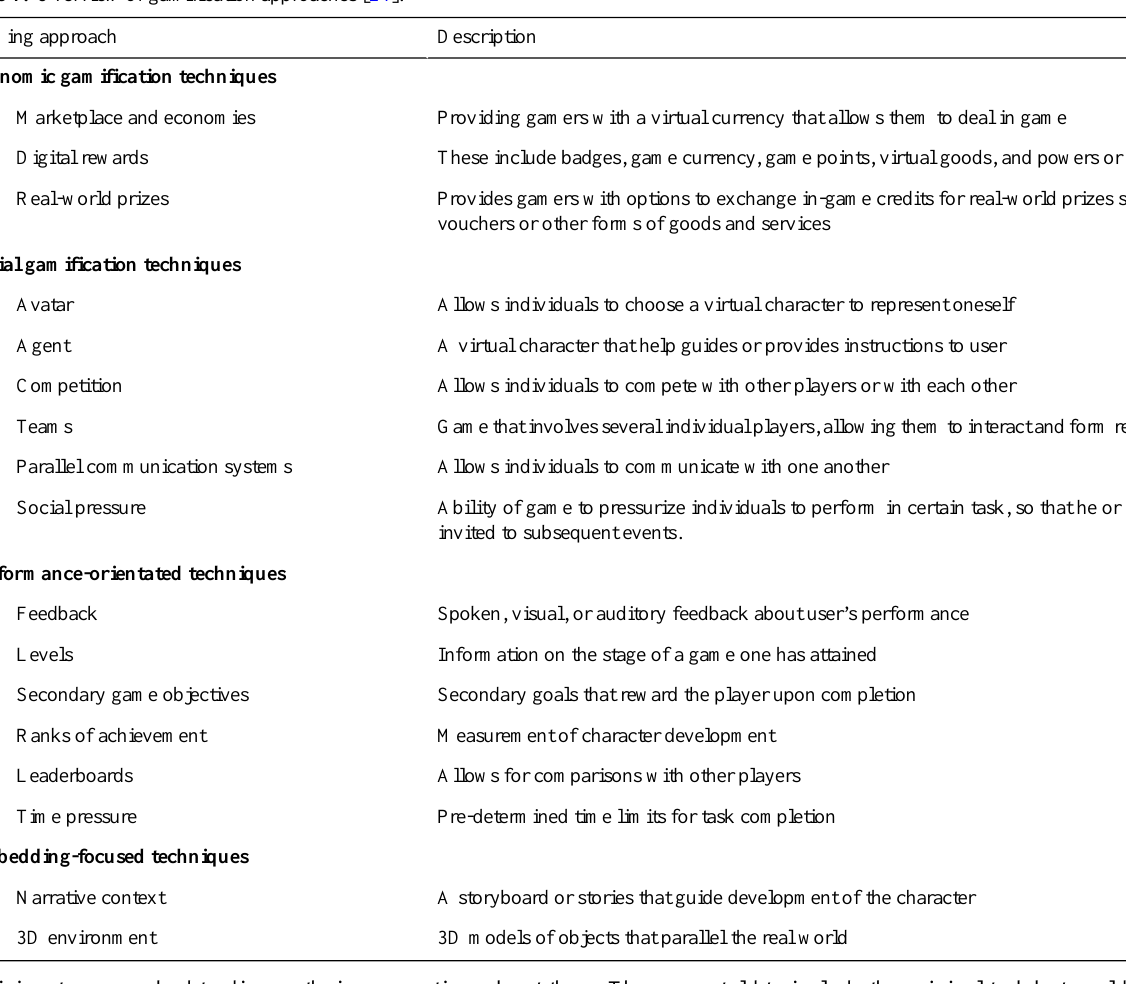
Table 1. Overview of gamification approaches